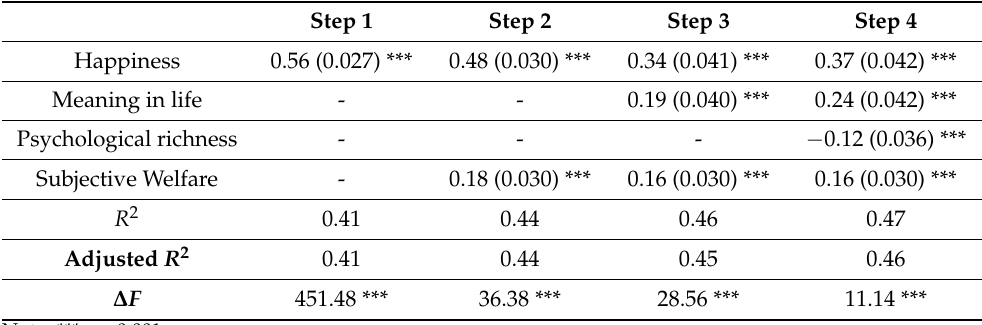
Table 5. Stepwise regression of a good life on the three wellbeing dimensions and subjective welfare (relative